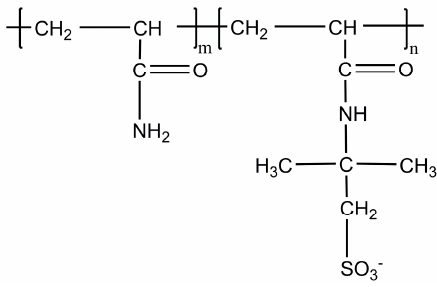
Figure 2. Molecular structure of sulfonated polyacrylamide polymers.